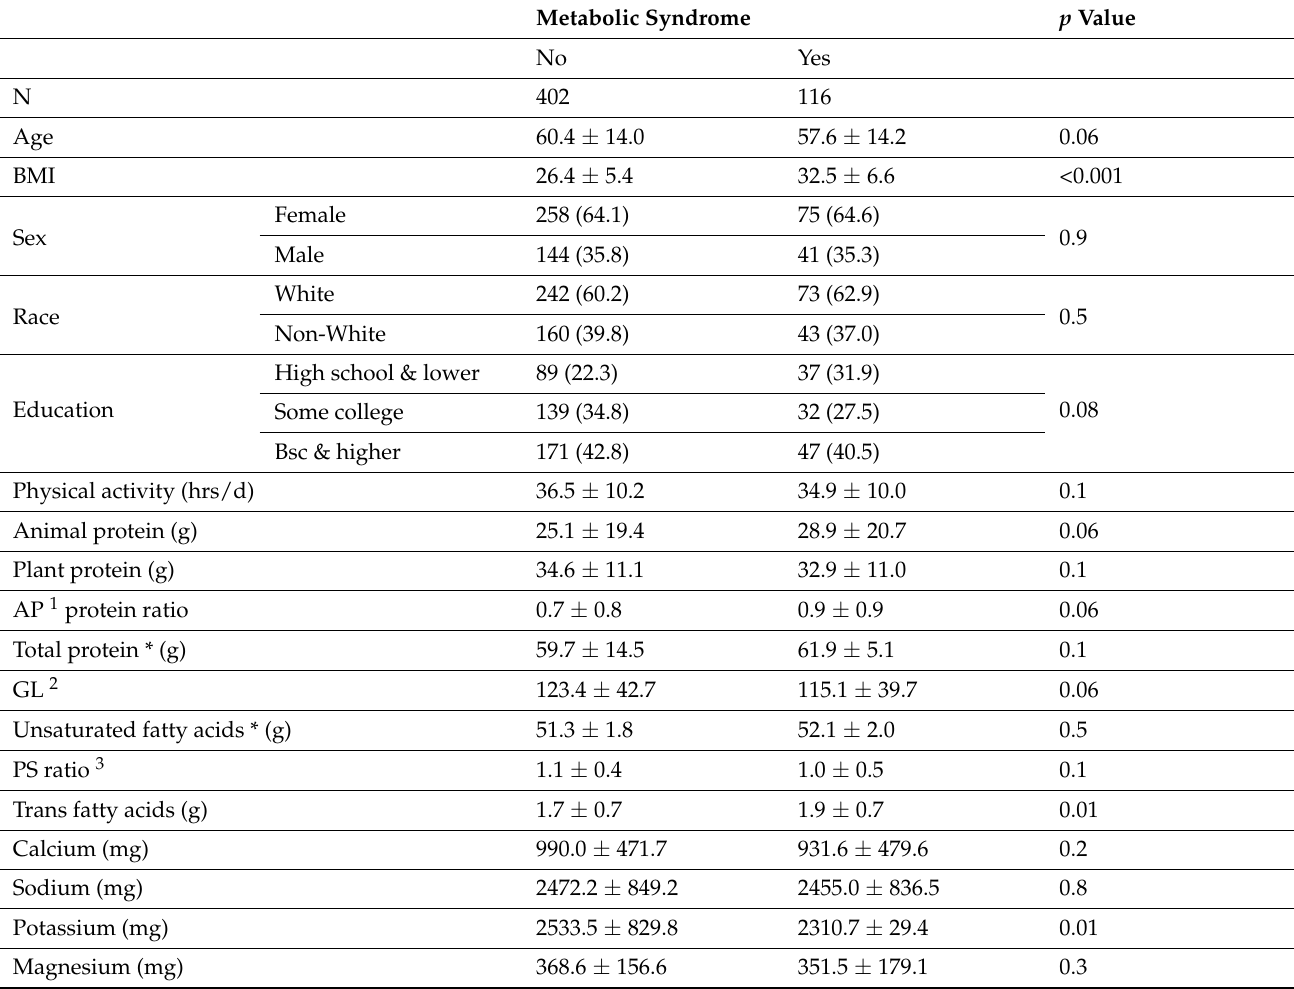
Table 1. Subject characteristics according to metabolic syndrome status.